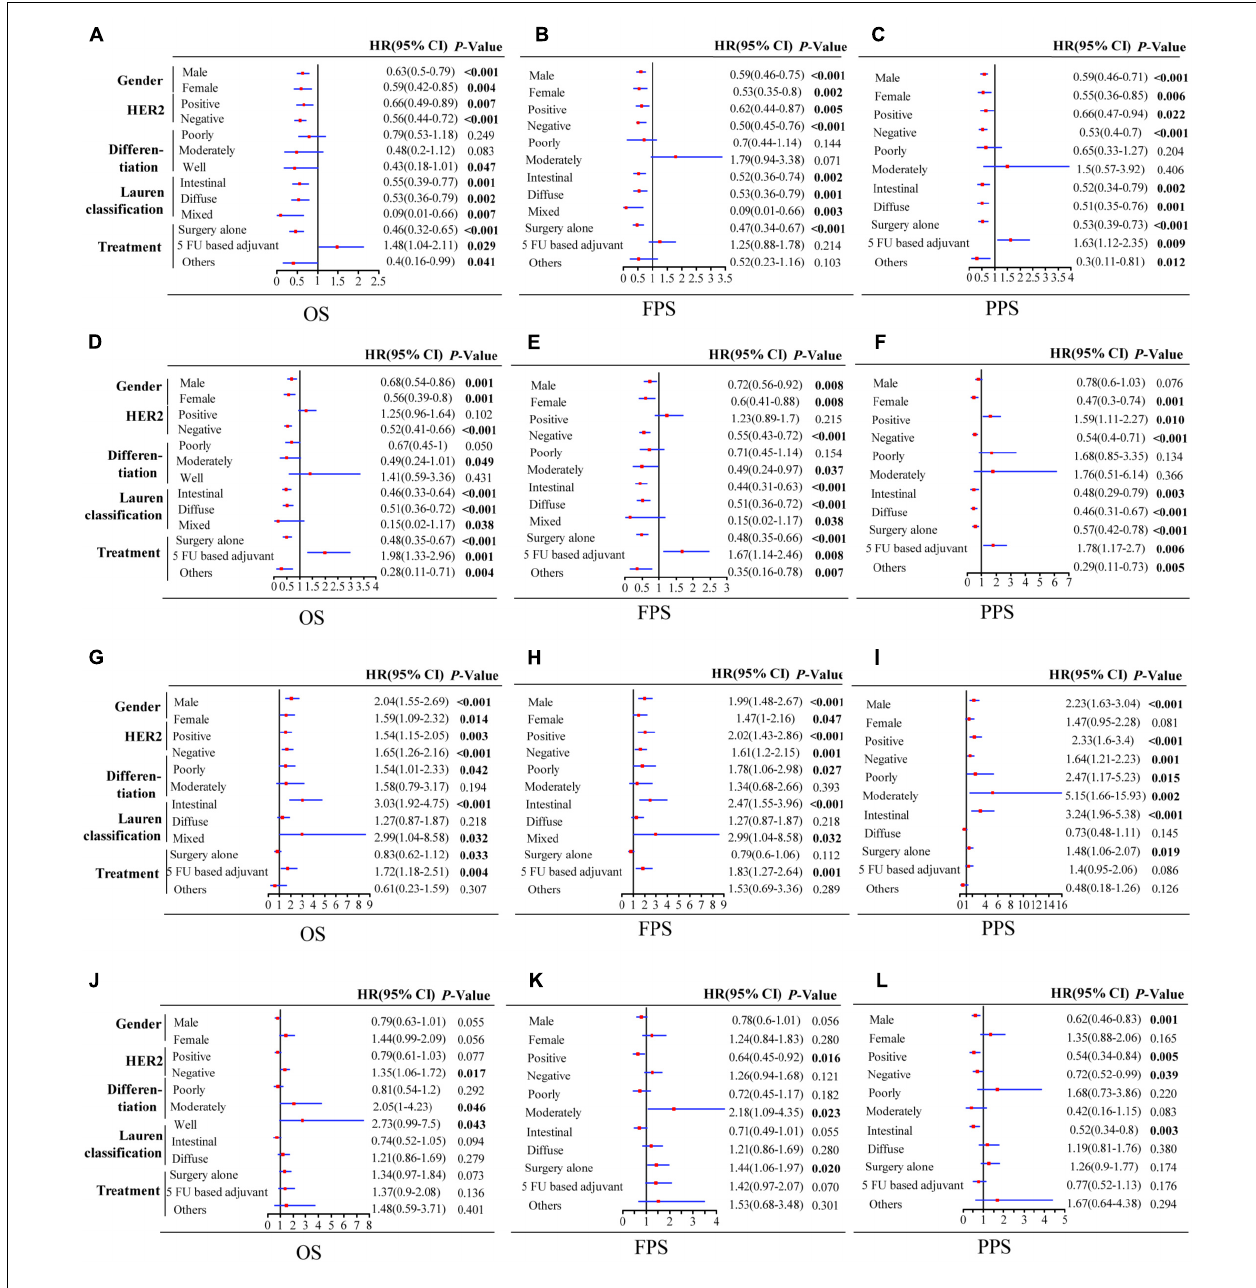
FIGURE 4 | Forest plot of individual expression level of PSME family genes with OS, FPS, and PPS in different clinicopathological feature patients with GC. PSME1 (A–C) ; PSME2 (D–F) ; PSME3 (G–I) ; and PSME4 (J–L) . The P -value was set at 0.05, and the bold values indicate that the results are statistically significant. OS, overall survival; FPS, first progression survival; PPS, post-progression survival; HR, hazard ratio; and CI, confidence